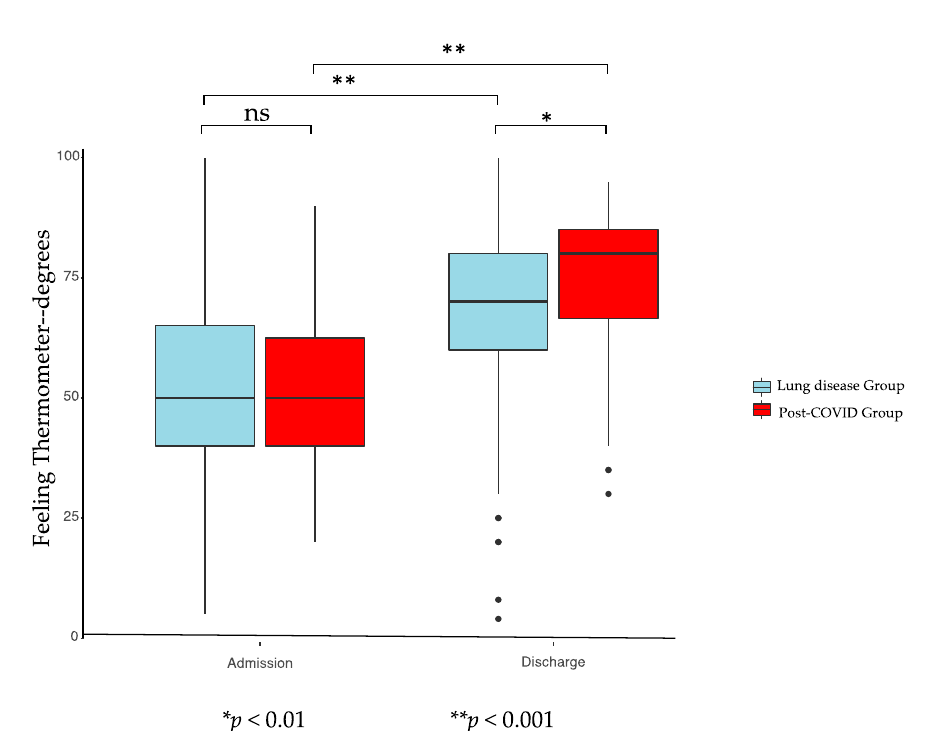
Figure 2. Feeling thermometer of post-COVID-19 group and lung diseases group. ns: no significative.